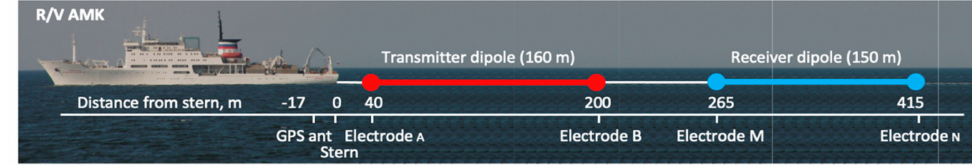
Figure 6. Typical configuration of the towed electrical array used in marine surveys for TDEM